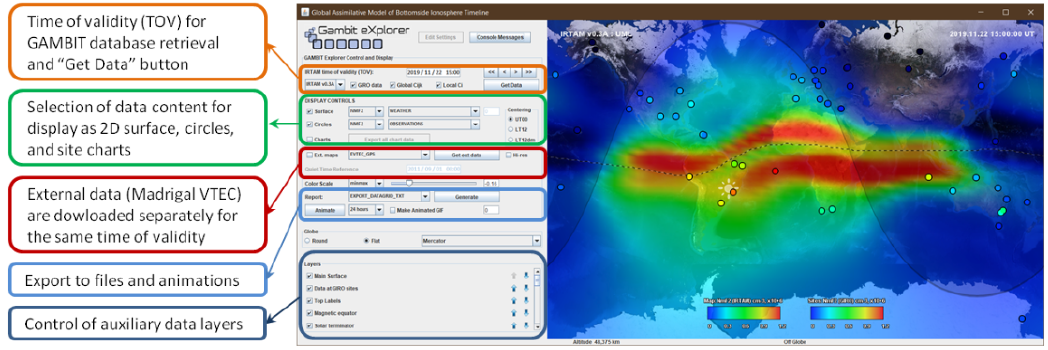
Figure 4. GAMBIT Explorer window. For more details refer to: http://giro.uml.edu/GAMBIT/